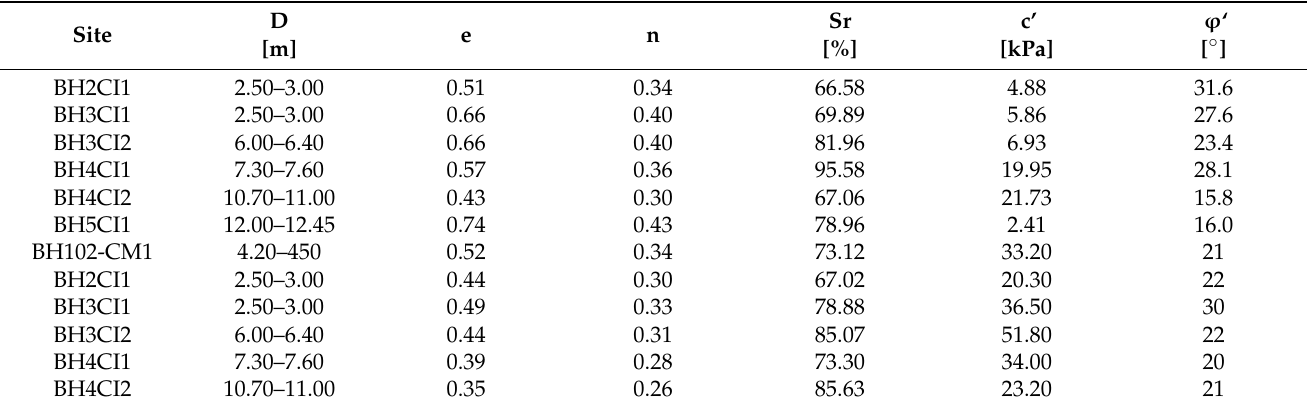
where: D = Depth, e = Void Ratio, n = Porosity, Sr = Degree of Saturation, c’ = Cohesion and φ ‘ = Effective friction angle from Direct Shear Test (DST).